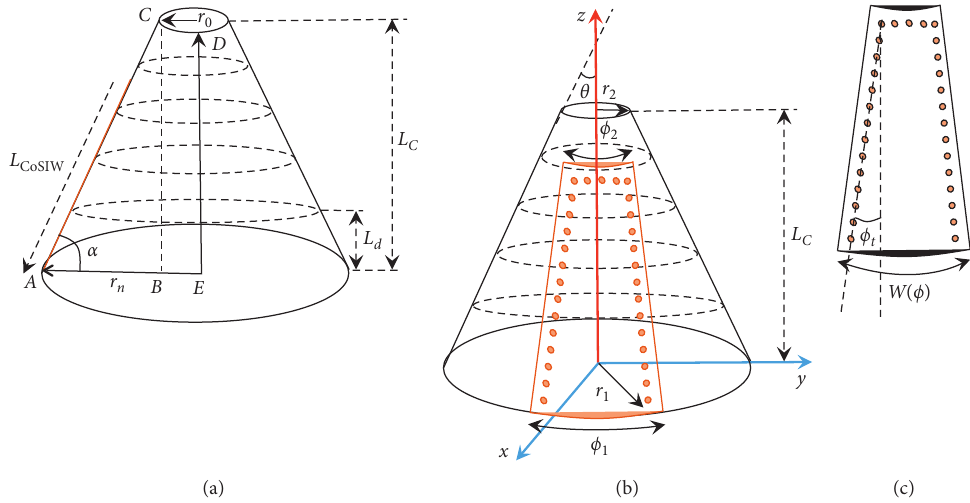
Figure 2: Cross-sectional view of nose-cone conformal SIW. (a) Side view. (b) Front view. (c) Tilted